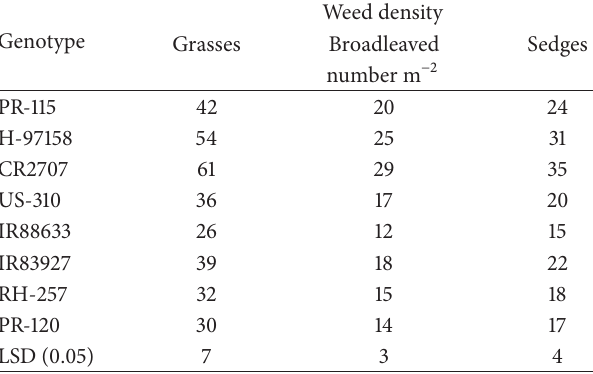
Table 1: Weed density (number m − 2 ) in response to different genotypes at 28 days after